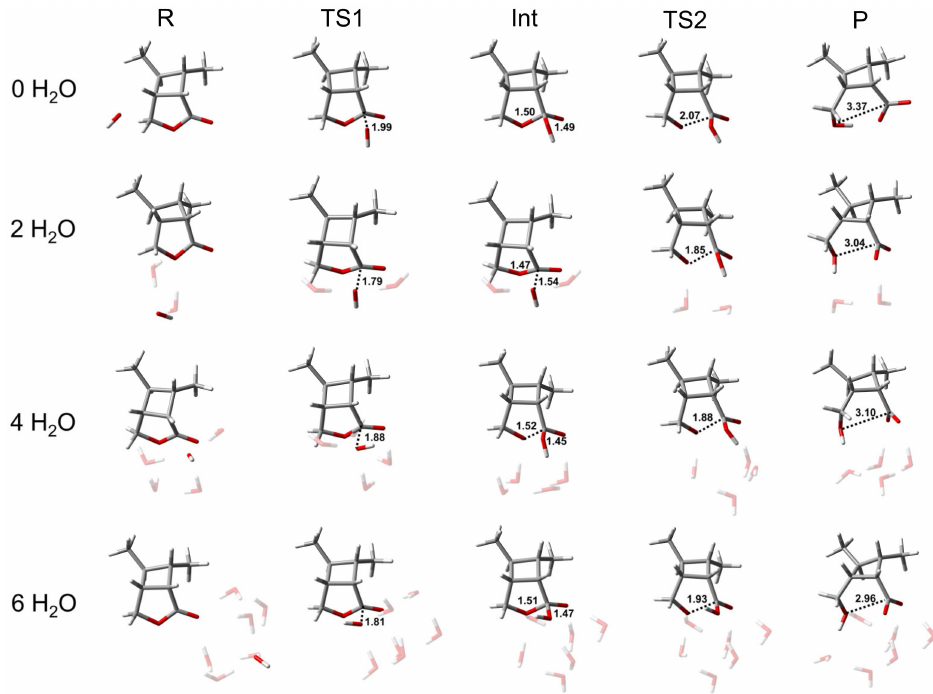
Figure 2. Representative structures of R, TS1, Int, TS2, and P of the B AC 2 reaction path of CBL, with varying numbers of H 2 O molecules. The unit of distance is Å. The coordinates of all optimized stationary points are provided in the Supplementary